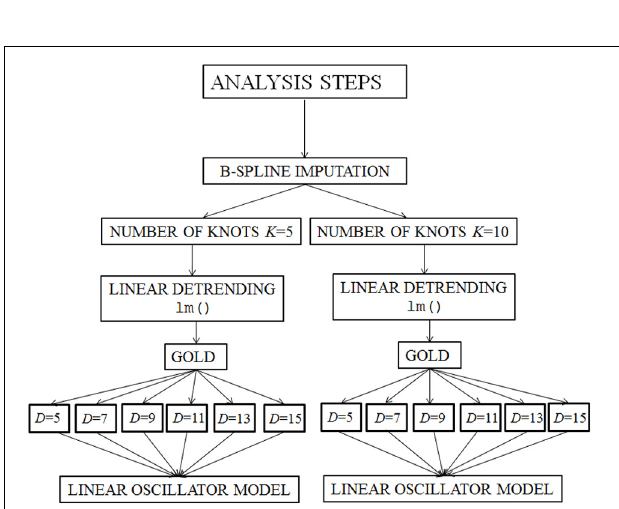
FIGURE 2 | Illustration of the applied method. K , number of knots in the B-spline imputation; LM, lm() function; GOLD, Generalized Orthogonal Local Derivatives; D , time-delay embedding